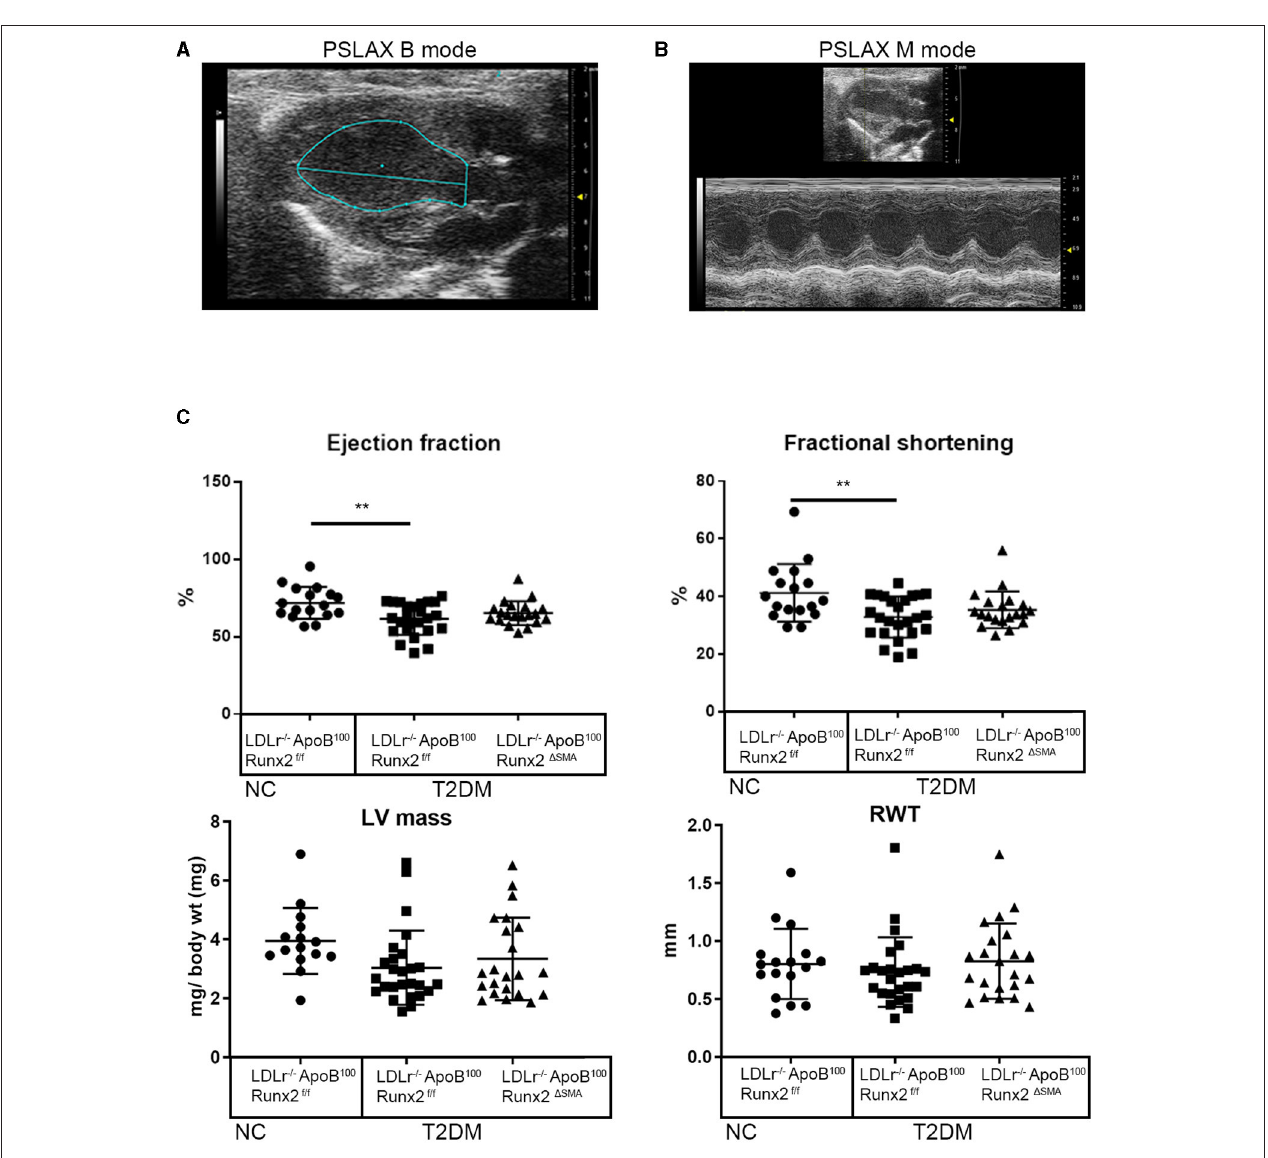
FIGURE 6 | SMA-specific depletion of Runx2 had no significant effect on ventricular function. Representative images of long-axis B-mode (A) and M-mode (B) images were used for the assessment of the left ventricular function. (C) Quantitative analysis of ejection fraction, fractional shortening, left ventricle mass (normalized to body weight), and relative wall thickness (RWT), between the 26 weeks LDLr − / − ApoB 100 Runx2 f / f normal chow (NC, n = 18), T2DM diet LDLr − / − ApoB 100 Runx2 f / f ( n = 25) and T2DM diet LDL r − / − ApoB 100 Runx2 1 SMA ( n = 20) groups. The differences between groups were analyzed by one-way ANOVA with Bonferroni’s correction ** p < 0.005. Data shown are mean ±